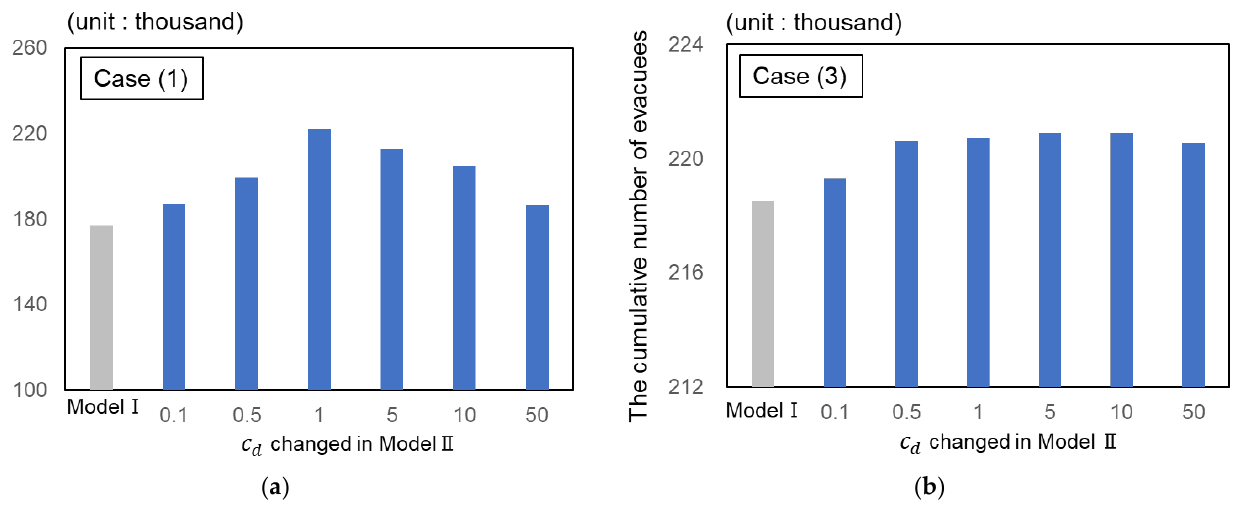
Figure 10. The cumulative number of successful evacuees when the model parameter C d is changed. (a) Case (1); (b) Case (3)